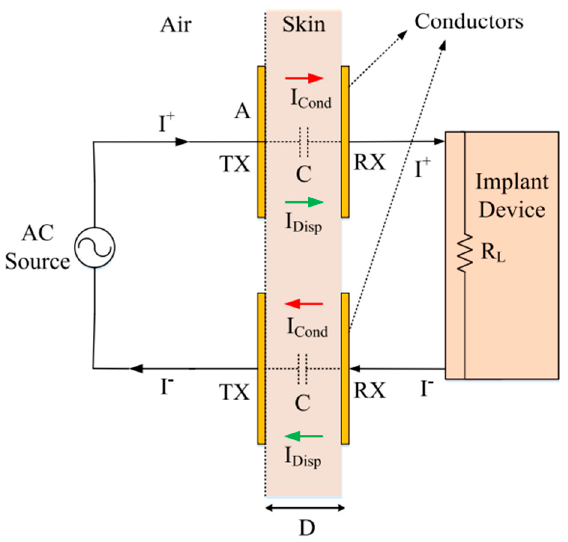
Figure 2. Non-radiative capacitive coupling (NRCC) method schematic (taken from [55]. Copyright © 2017, IEEE).